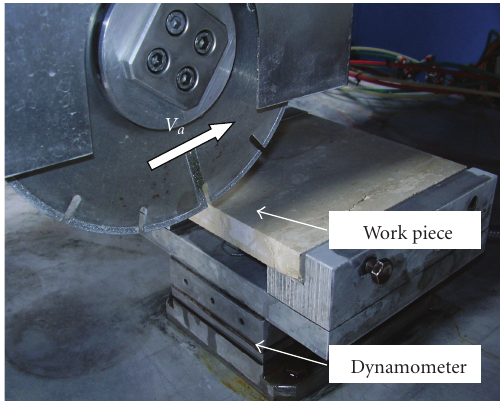
Figure 1: Stone machining